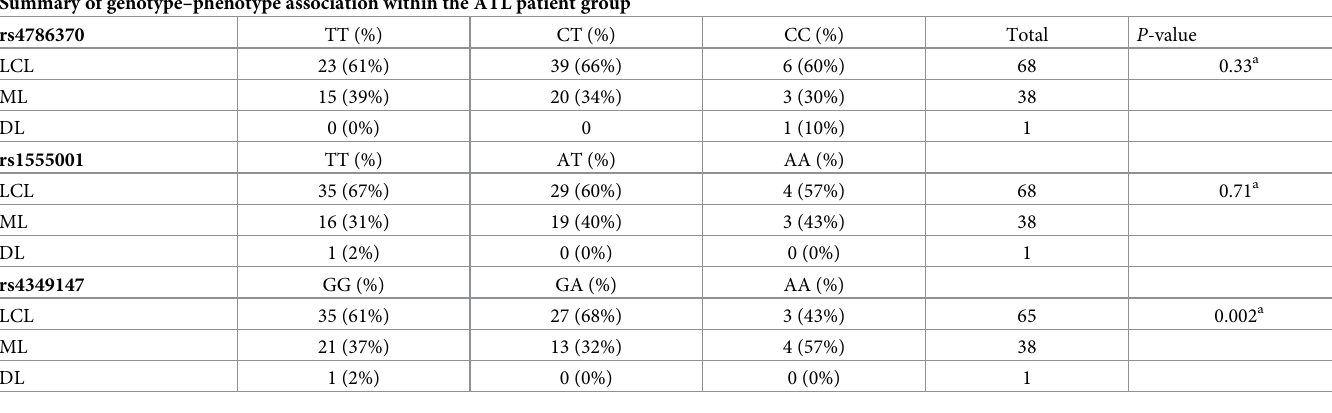
Summary of genotype–phenotype association within the ATL patient